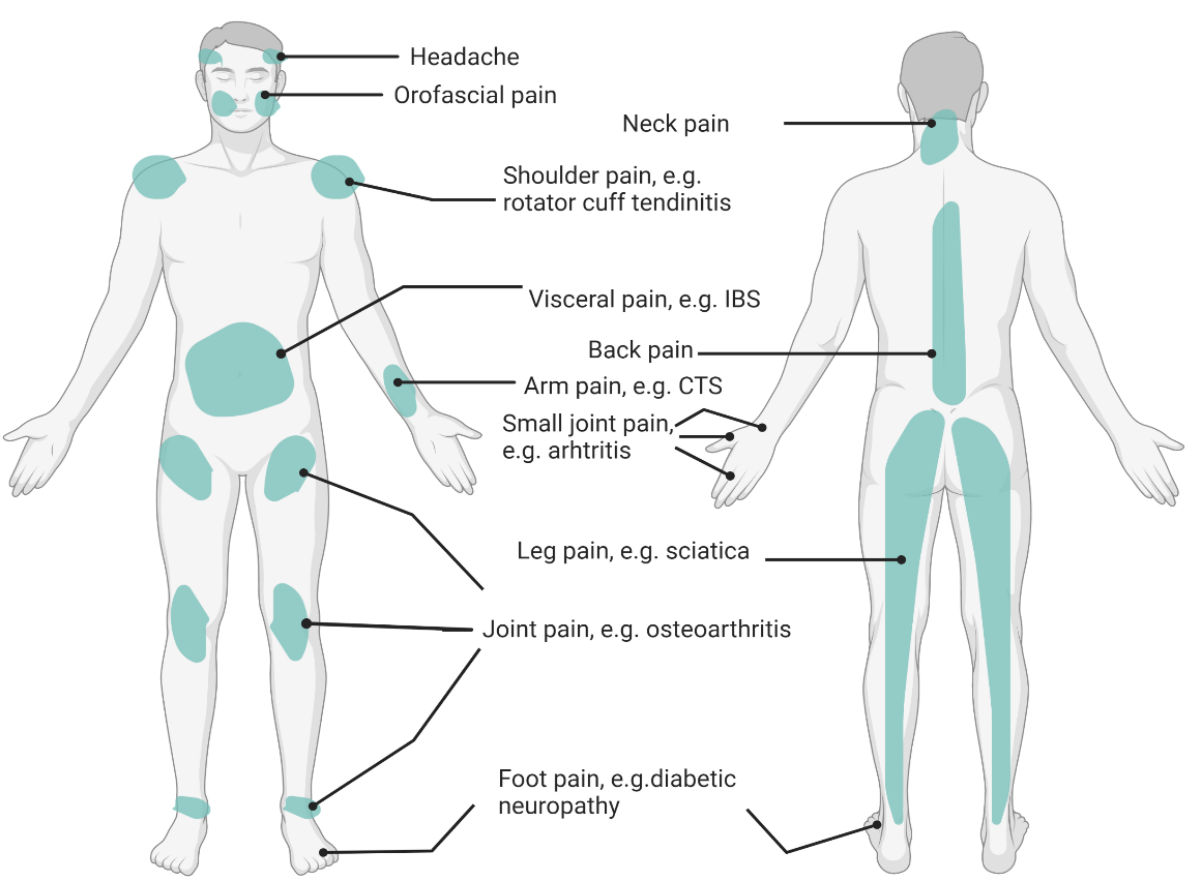
Figure 1. Pain Sites Related to Poor Nutrition. IBS: Irritable Bowel Syndrome; CTS: Carpal Tunnel Syndrome .